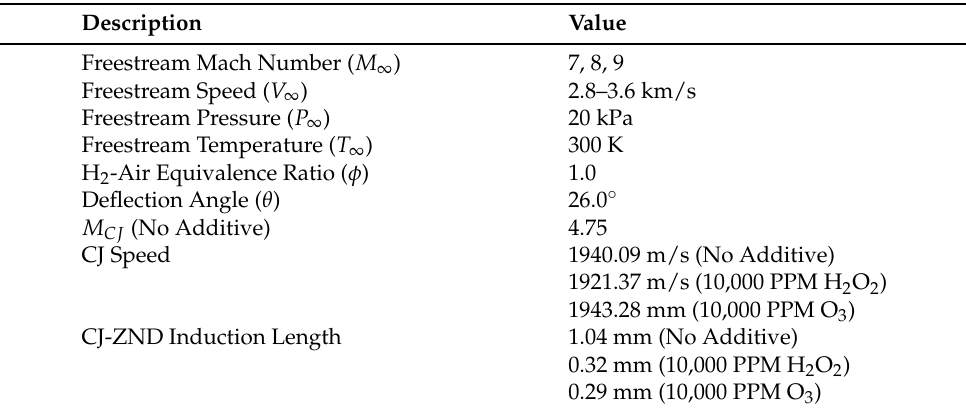
Table 1. Boundary Condition and Flow